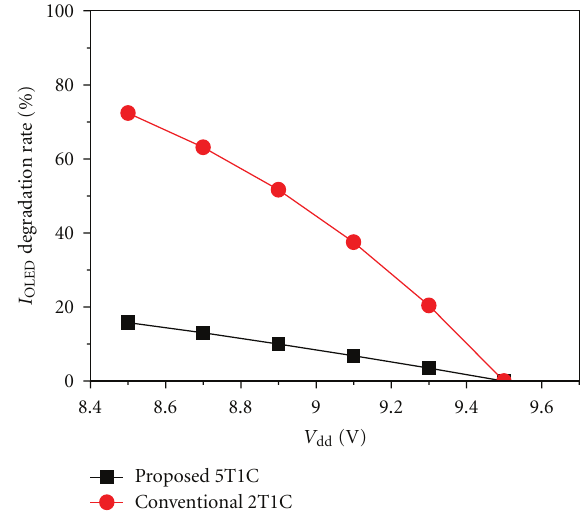
Figure 6: Comparison of output current degradation rate versus V dd drop for conventional 2T1C pixel circuit and proposed pixel